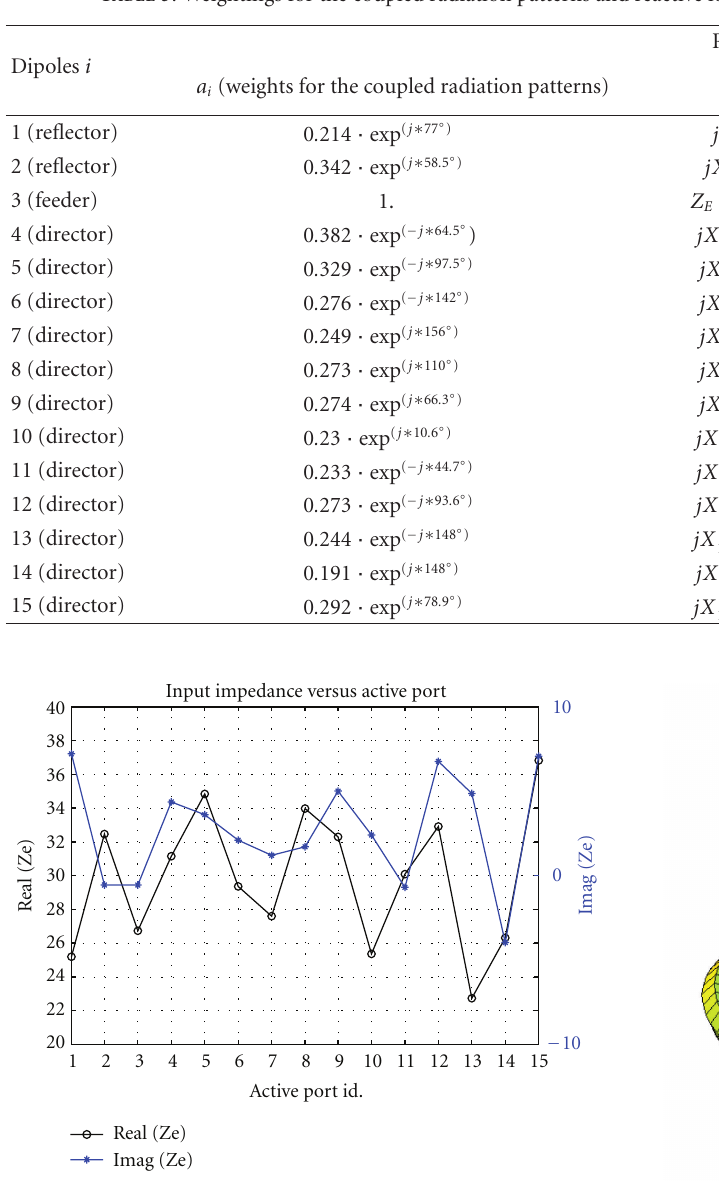
Figure 27: Input impedance versus the feeding port index (port id.).